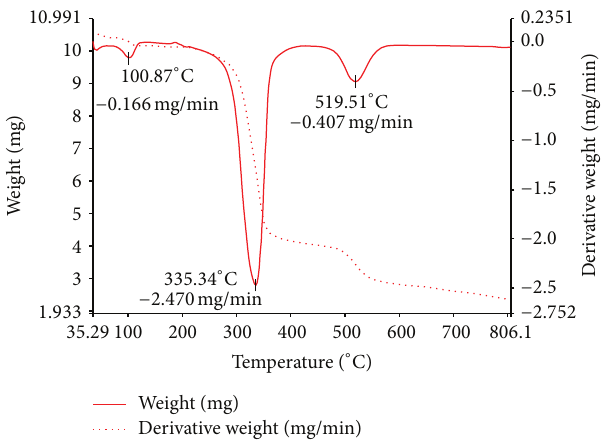
Figure 3: TG-DTA curve of Cu(II) complex.